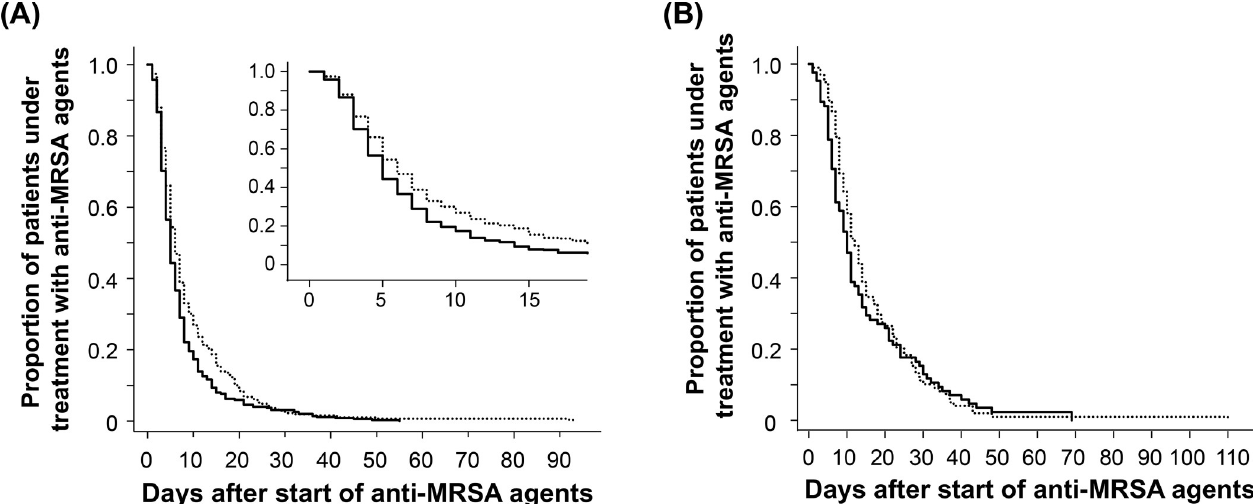
Fig 4. Subgroup analysis of the effect of PAF implementation on the time to de-escalation of anti-MRSA agents. The time to de-escalation in two subgroups was estimated using the Kaplan–Meier method. Panels A and B show Kaplan–Meier curves for the “discontinuation” and “oral switch” subgroups, respectively. The “discontinuation” subgroup included 309 and 352 cases from the pre- and post-PAF periods, respectively, and the “oral switch” subgroup included 98 and 85 cases from the pre- and post-PAF periods, respectively. Dotted and solid lines represent Kaplan–Meier curves for the pre- and post-PAF periods, respectively. PAF implementation significantly shortened the time to de-escalation (median 5 days vs . 6 days, P = 0.002, generalized Wilcoxon test) in the “discontinuation” subgroup. In contrast, PAF implementation had no significant effect on the time to de-escalation (median 10 days vs . 12 days, P = 0.082) in the “oral switch” subgroup. The inset in panel A shows the same data on an enlarged horizontal